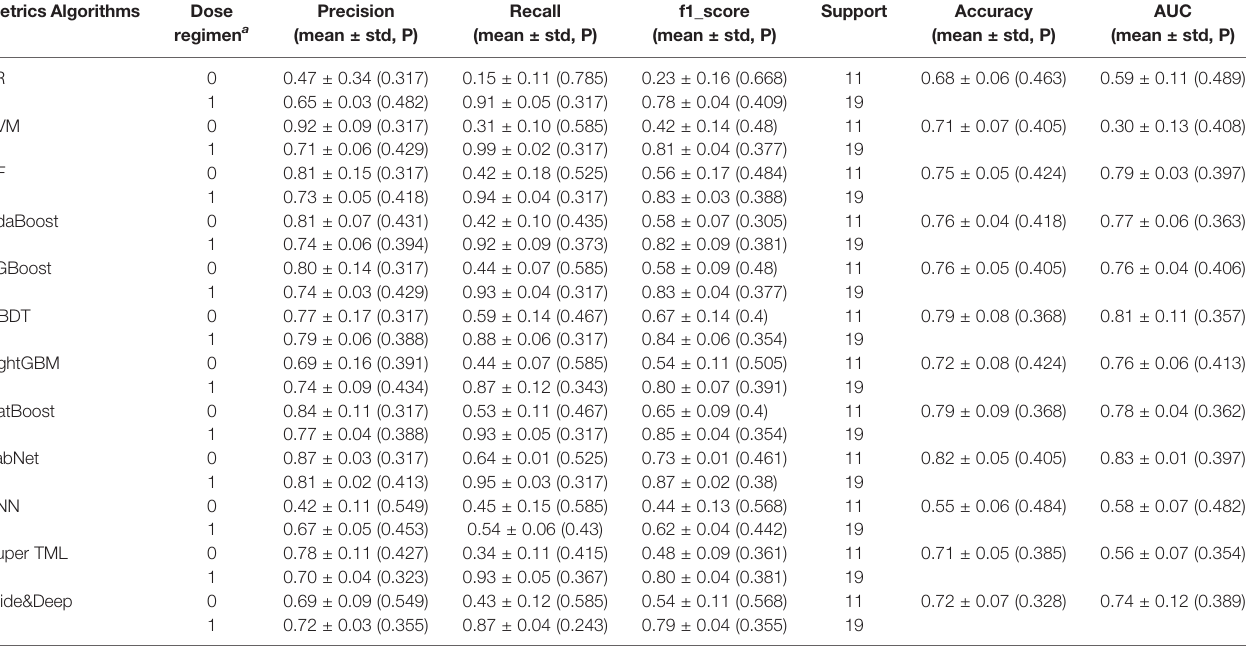
TABLE 1 | Prediction performance of different algorithms with six-fold cross-validation. Metrics